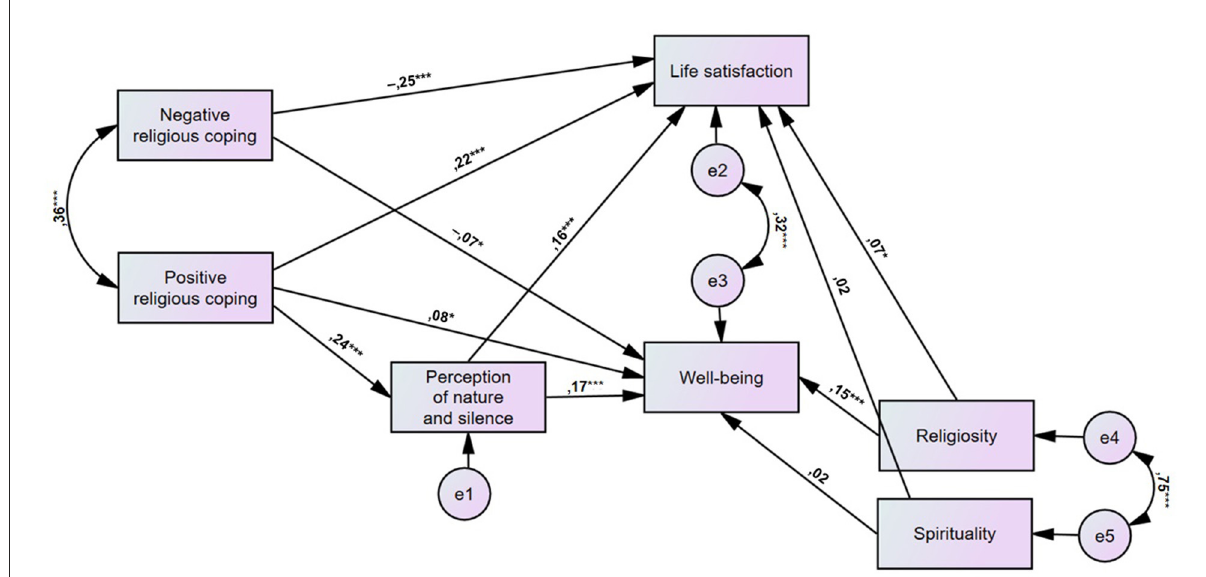
FIGURE1 Study model: Relationships between religious coping, perception of nature and silence, satisfaction with life, and well-being ( N = 1,010; * p < 0.05, *** p <